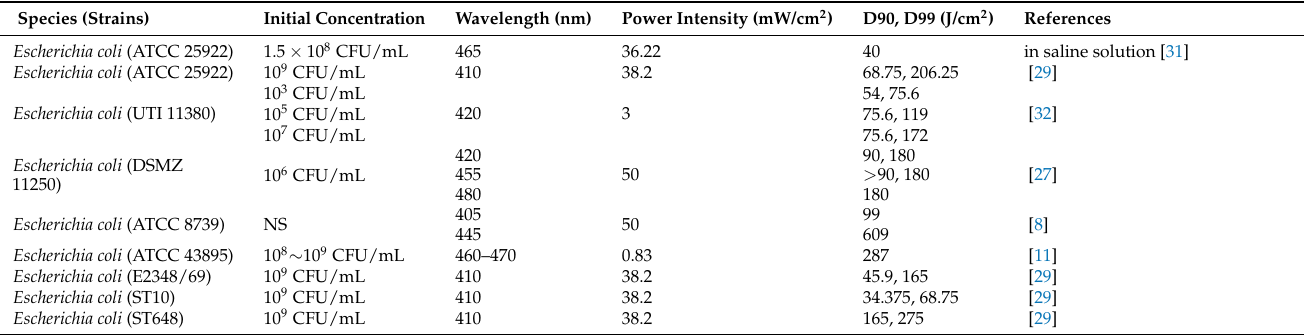
Table 1. Summary of continuous blue light inactivation of planktonic bacteria ( D c =